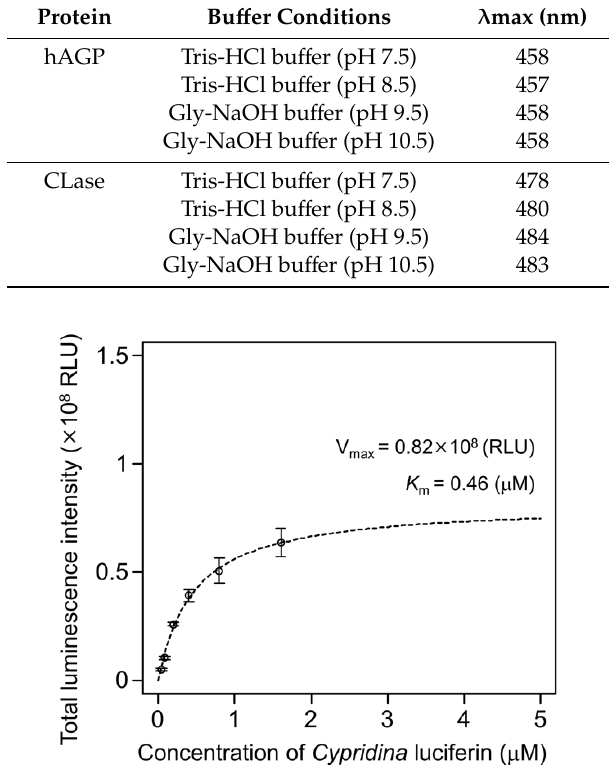
Figure A2. Luminescence intensity of various concentrations of Cypridina luciferin with hAGP under a Gly-NaOH (pH 9.5) buffer condition: the bars represent the mean values ± SD for n = 3.